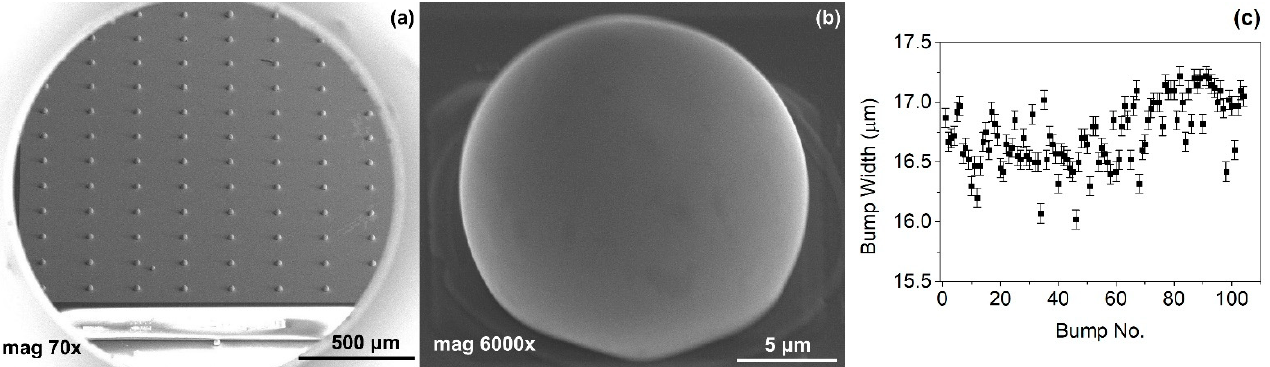
Figure 5. ( a ) A low magnification SEM image of a square with indium bump array; ( b ) a high magnification SEM image of a single bump fabricated using technology with additional annealing; ( c ) error bar graph of bump widths measured using SEM microscopy.